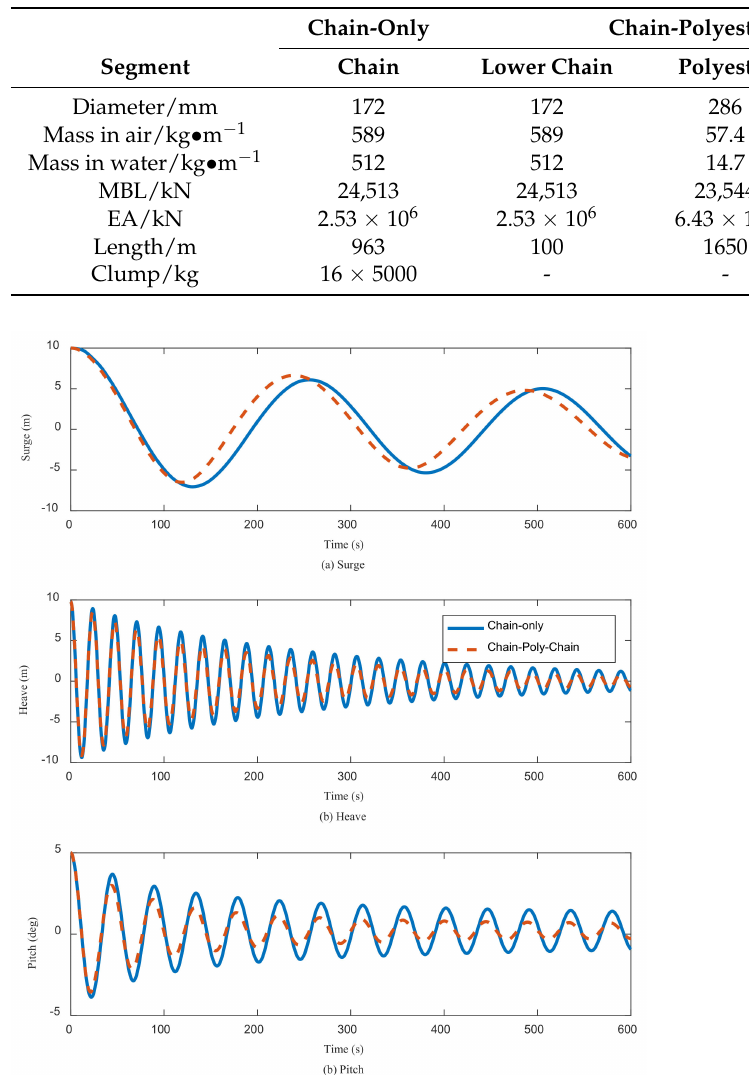
Table 3. Parameters of the mooring line [29].